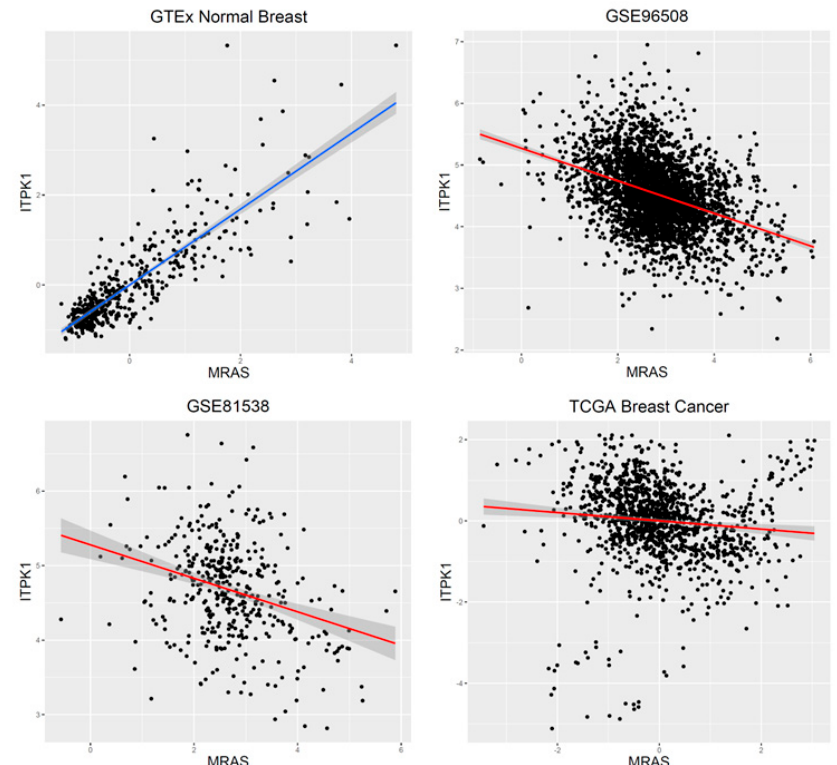
Figure 4. Differential coexpressions between MRAS and ITPK1 genes. Please note that MRAS and ITPK1 show a highly positive correlation in normal breast, while the show a negative correlation in the breast cancer data. GTEx, Genotype Tissue Expression project; TCGA, The Cancer Genome Atlas project.